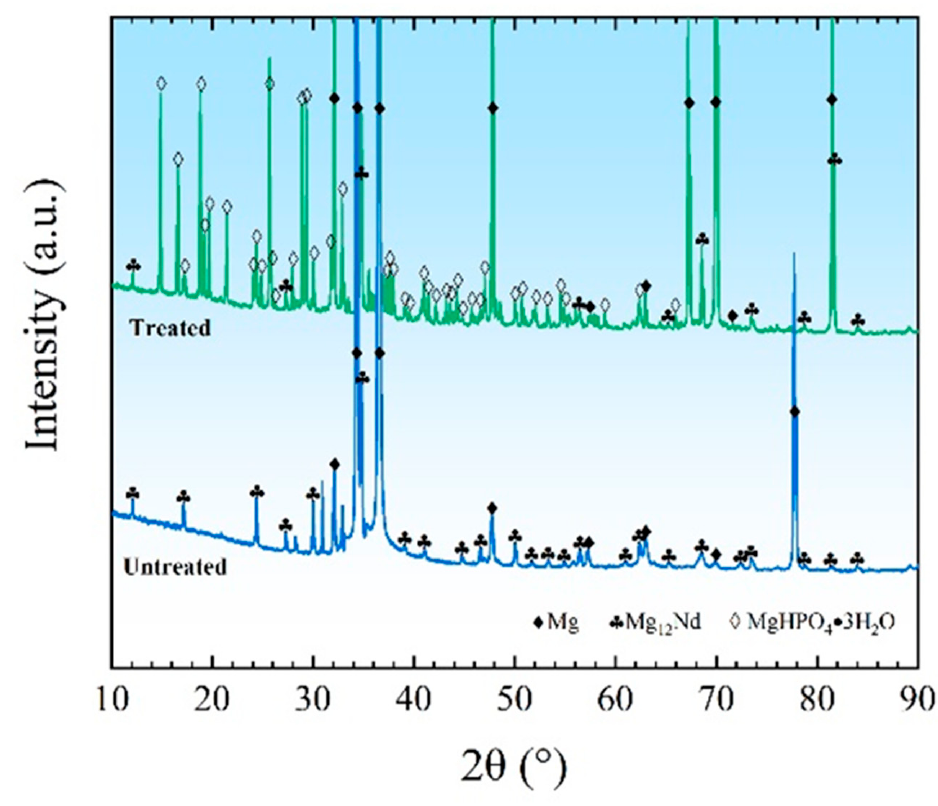
Figure 2. XRD patterns of the untreated sample and the sample treated by uniform corrosion.